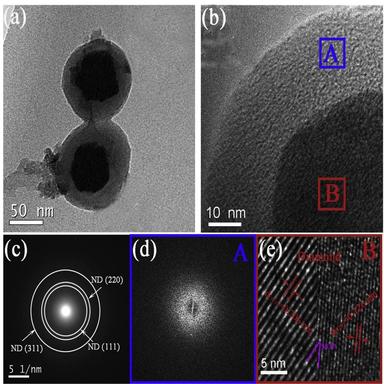
(a) Typical TEM image of the D@C-1.0, (b) HRTEM of the D@C-1.0, (c) the SAED image of the (a), (d) FFT image of the region "A" in (b), (e) the corresponding to HRTEM of the region "B" in (b).